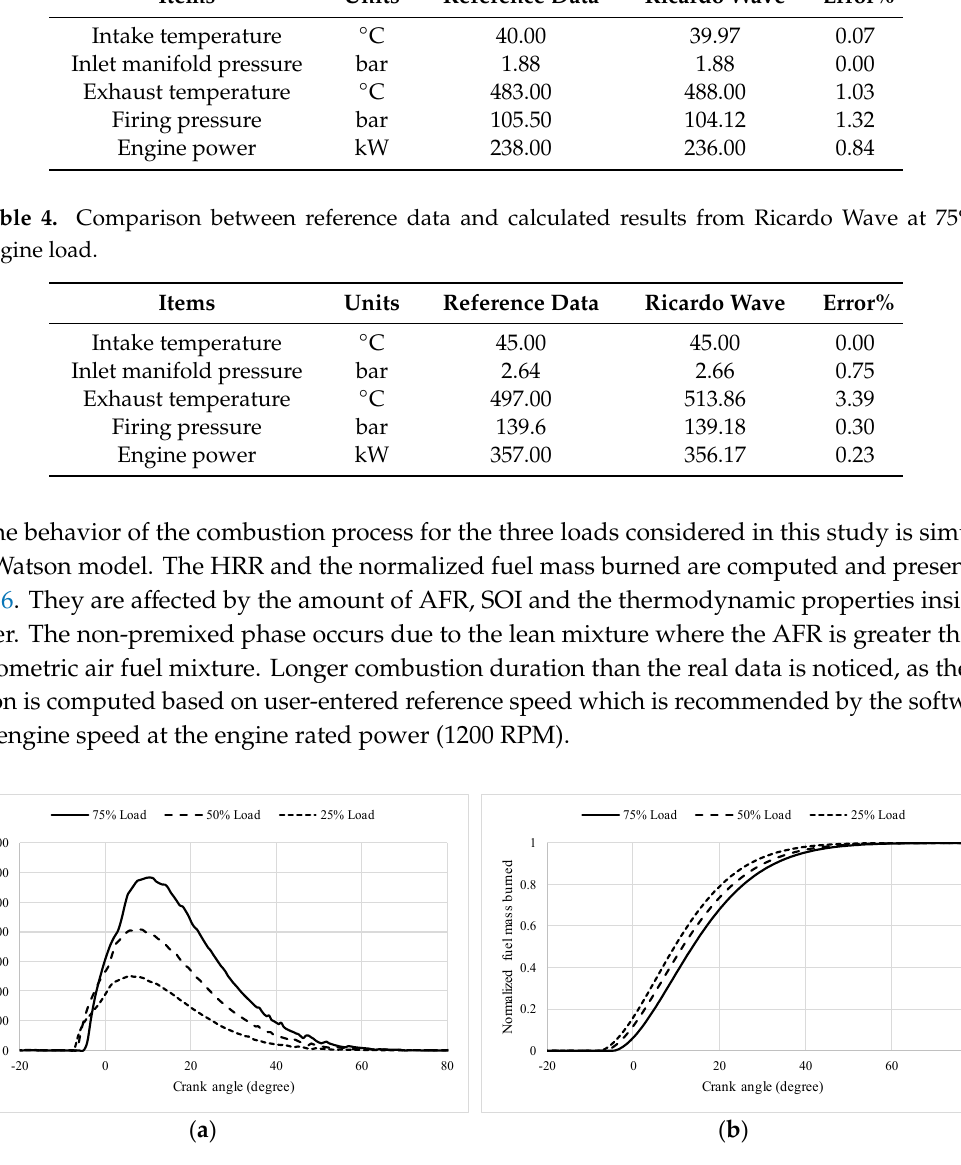
Figure 6. ( a ) Heat release rate and ( b ) normalized fuel mass burned for different engine loads. Table 2. Comparison between reference data and calculated results from Ricardo Wave at 25% engine load.